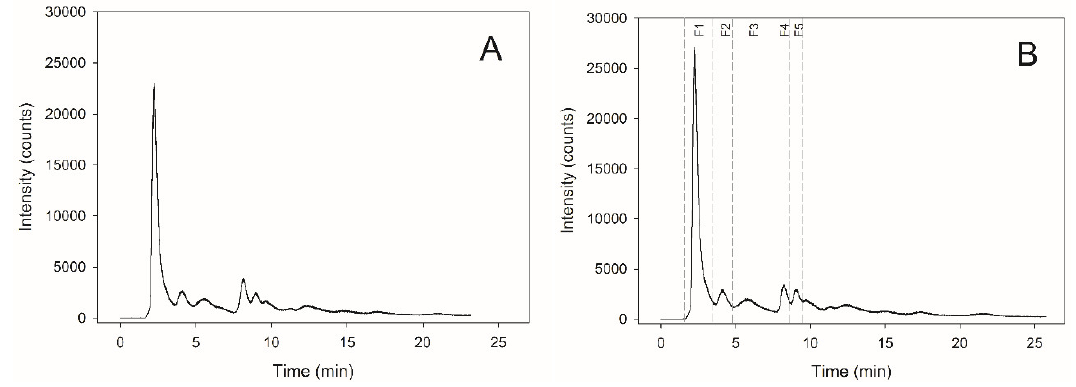
Figure 2. Chromatogram obtained for extract- C. utilis ATCC 9950 ( A ) and concentrated extract C. utilis ATCC 9950 ( B ).